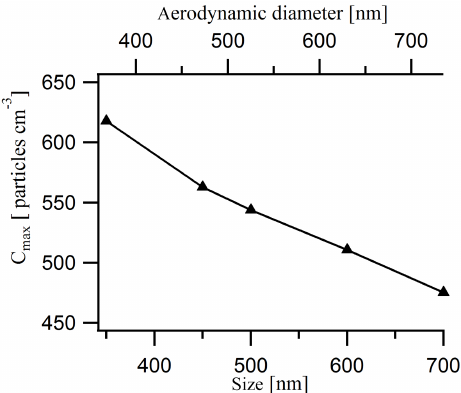
Figure 12. Variation of C max for particles with different aerody- namic